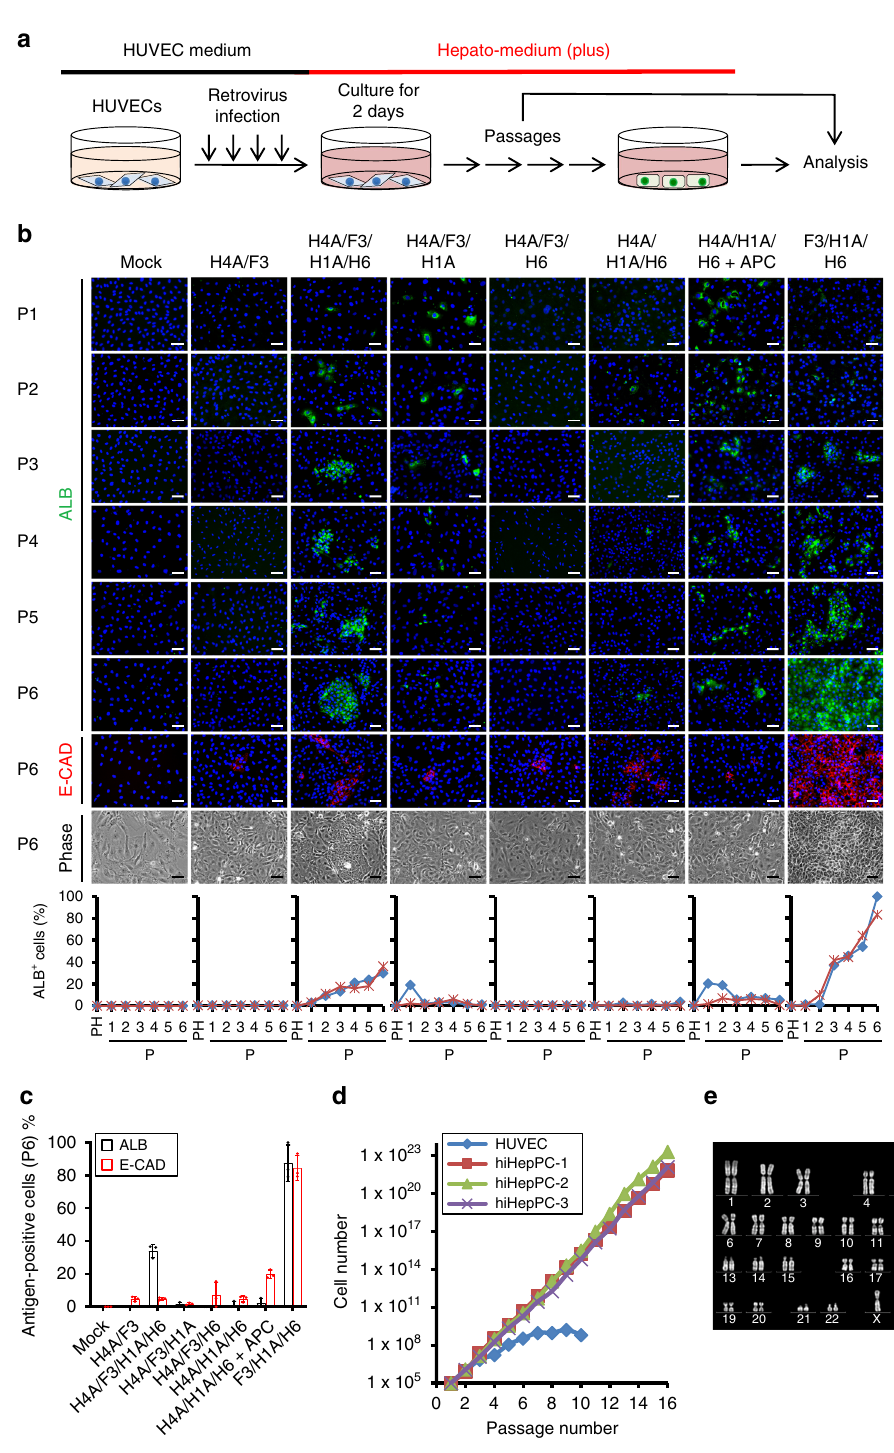
Fig. 1 Generation of expandable hiHepPCs from HUVECs. a Schematic diagram of the experimental procedure. b Immuno fl uorescence staining of ALB or E-CAD was conducted for mock-infected HUVECs and HUVECs transduced with the indicated factors at the indicated passage numbers (P). HNF4A, FOXA3, HNF1A, and HNF6 are abbreviated as H4A, F3, H1A, and H6, respectively. Representative fl uorescence images and morphologies of mock-infected and transduced HUVECs are shown. DNA was stained with DAPI. Scale bars, 50 µ m. The graphs show the percentages of ALB + cells observed in individual cultures during passaging. The data obtained from two independent experiments are indicated by red and blue lines in the graphs, respectively. PH parental HUVEC. c The percentages of cells immunoreactive for ALB or E-CAD among mock-infected HUVECs and HUVECs transduced with the indicated factors at passage (P) 6. Data represent the mean ± SD ( n = 3 independent experiments). d Growth curves of mock-infected HUVECs and three different hiHepPCs generated by transducing HUVECs with FOXA3 , HNF1A , and HNF6 in three independent experiments. Cells (1 × 10 5 ) were passaged every 7 days in wells of 6-well plates. e A representative image of a karyotype of a hiHepPC at passage 12. Note that the numbers of chromosomes in all 20 hiHepPCs analyzed in this study were normal. Source data are provided as a Source Data fi